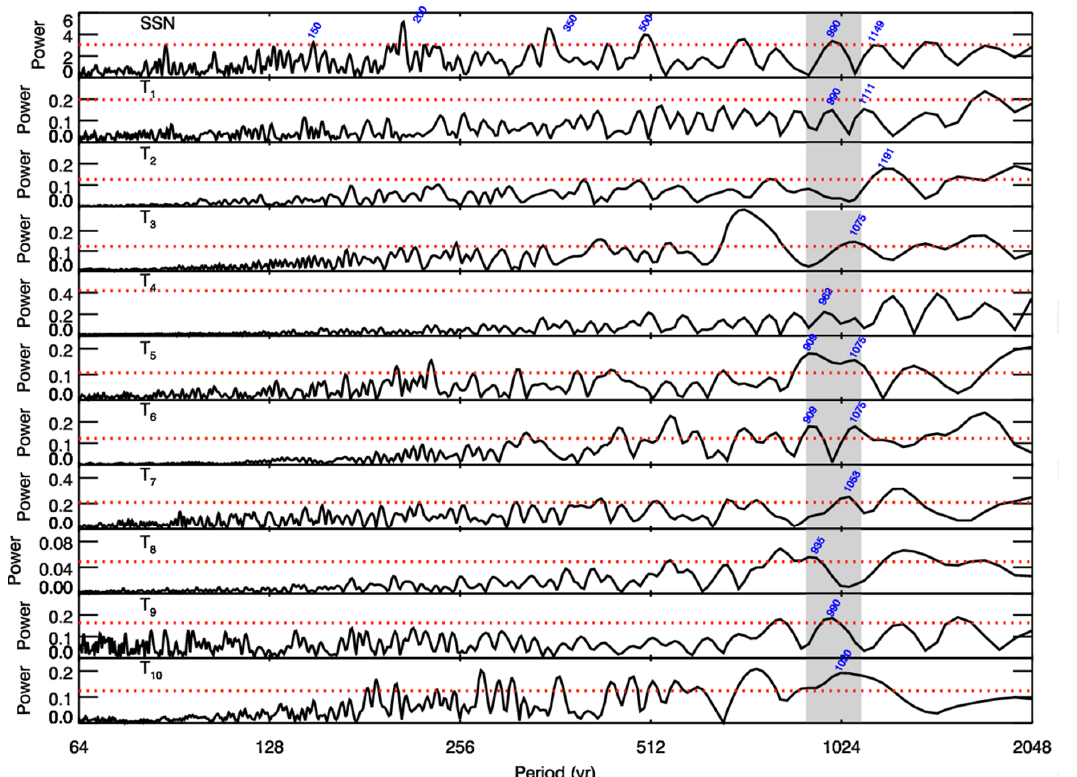
Figure 2. The Lomb–Scargle periodograms of SSN and 10 temperatures on Earth during the study interval (BC 7290–AD 1850). The red horizontal dotted lines denote the 95% confidence levels. The shaded region represents the Eddy cycle (roughly 900 years to 1100 years).